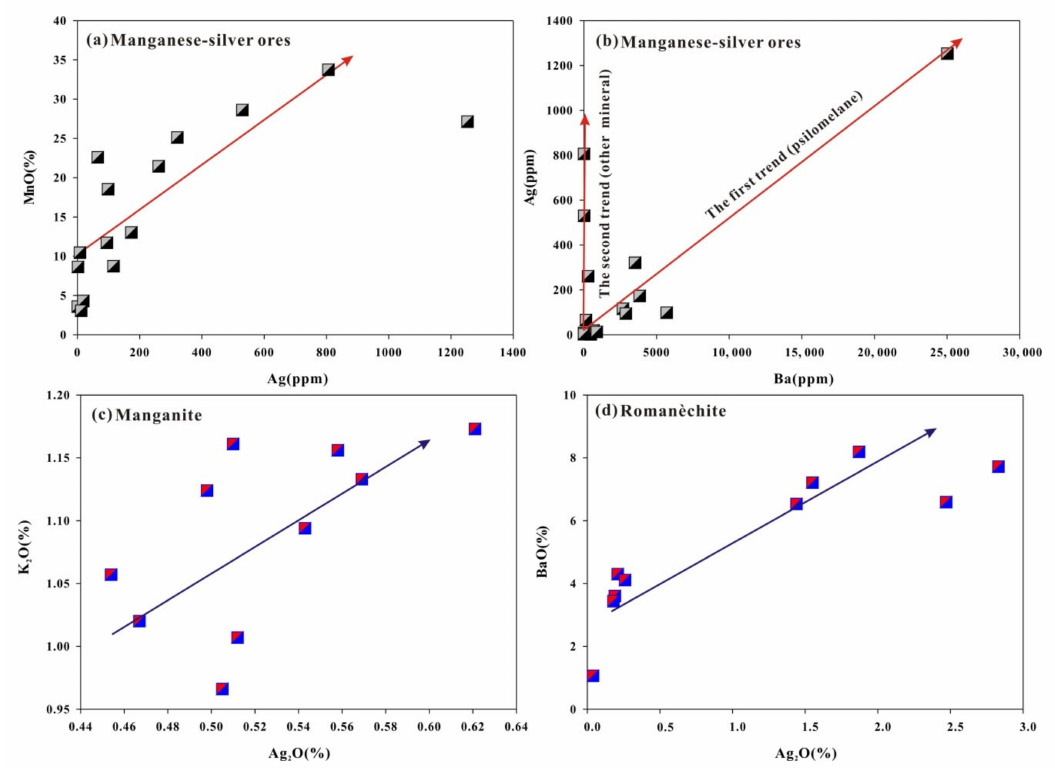
Figure 6. Correlation between Ag and other elements of the Sanbao Mn–Ag ore: ( a ) Ag has a positive correlation with Mn; ( b ) Two types of variation tendencies between Ag and Ba content: first, a positive correlation between Ag and Ba content in a Ba-bearing mineral. Second, Ag content increases while Ba content remains unchanged at a lower level. This tendency shows that another Ag-bearing manganese mineral is Ba-poor; ( c ) A positive correlation between Ag and K content in the pure manganite; ( d ) A positive correlation between Ag and Ba content in the pure roman è